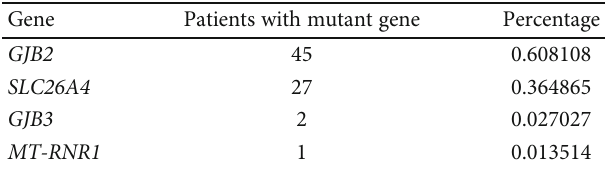
Table 3: The genetic spectrum of hereditary hearing loss patients detected by 159 variant